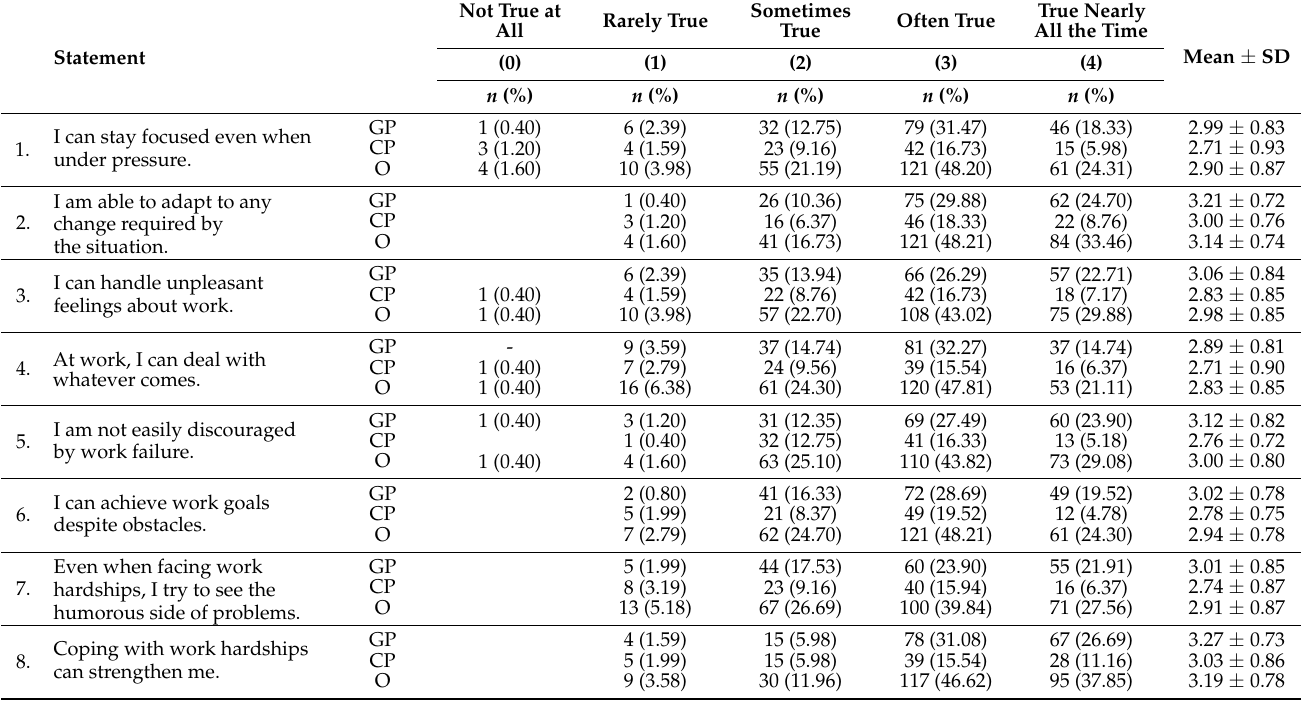
Table 3. Rating distribution was assessed using the Connor–Davidson resilience scale-10 ( n =